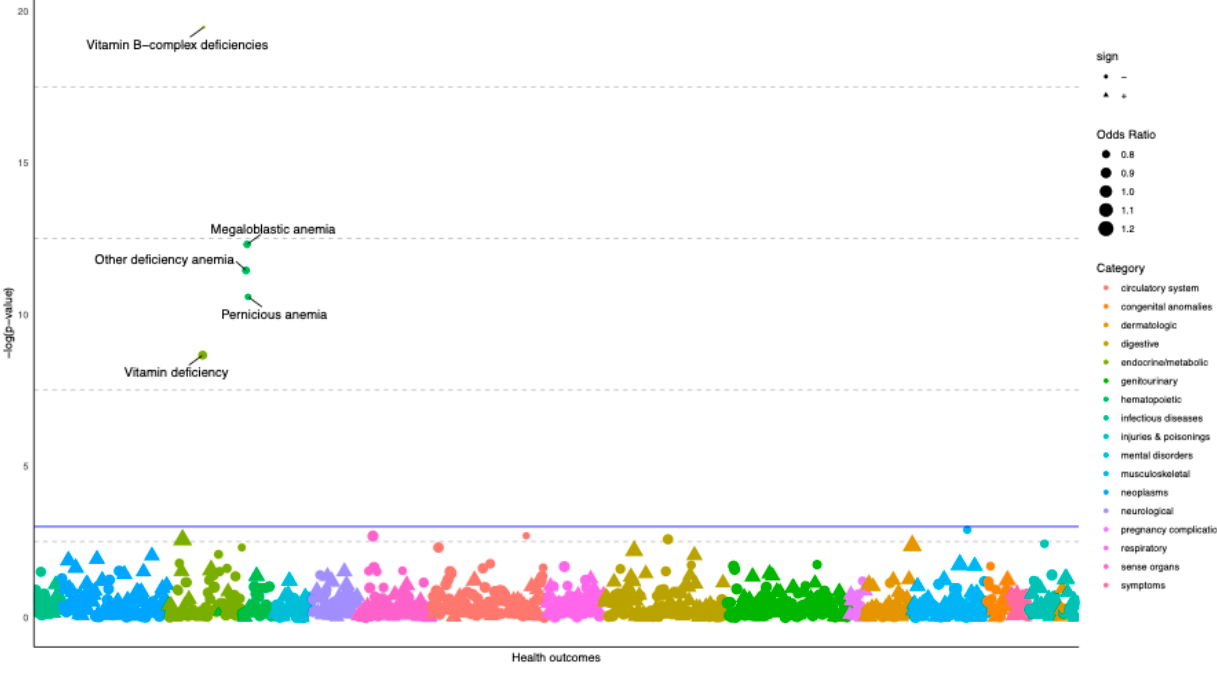
Figure 1. Manhattan plot depicting associations between a genetic risk score of vitamin B 12 status and 945 health outcomes in the UK Biobank.